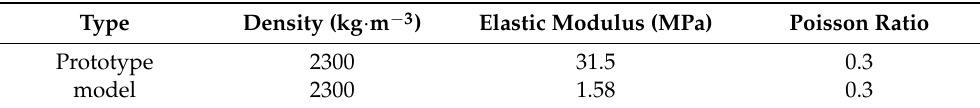
Table 2. Physical and mechanical parameters of tunnel materials.